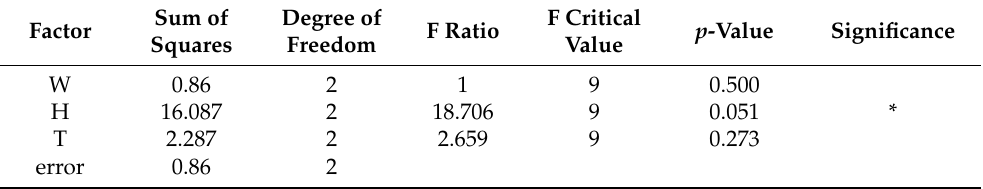
error Significant level α = 0.1.